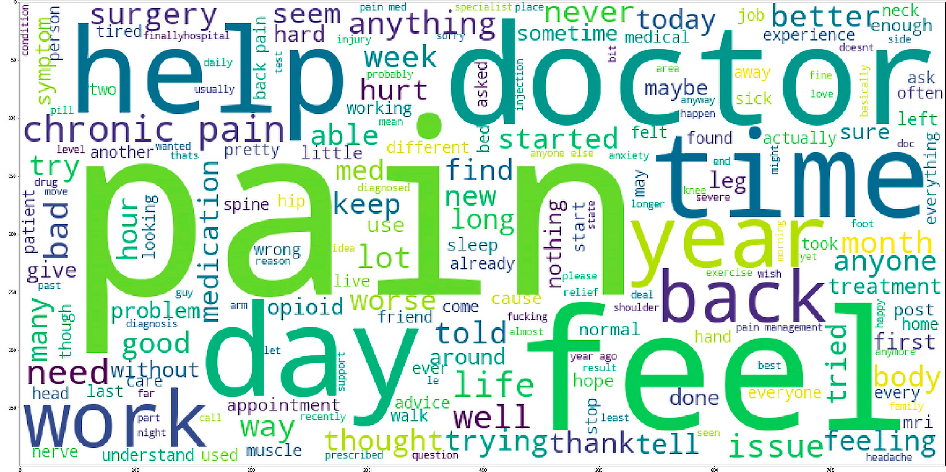
Figure 2. Word cloud of posts on the subreddit called r/ChronicPain.